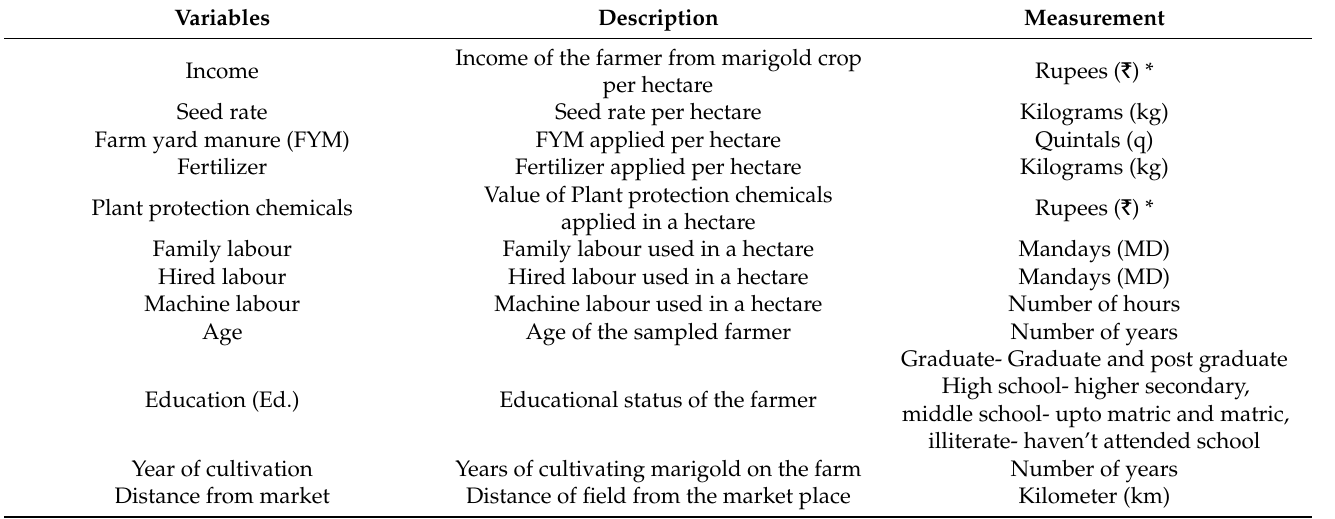
Table 12. Description of the explanatory variables used in the regression